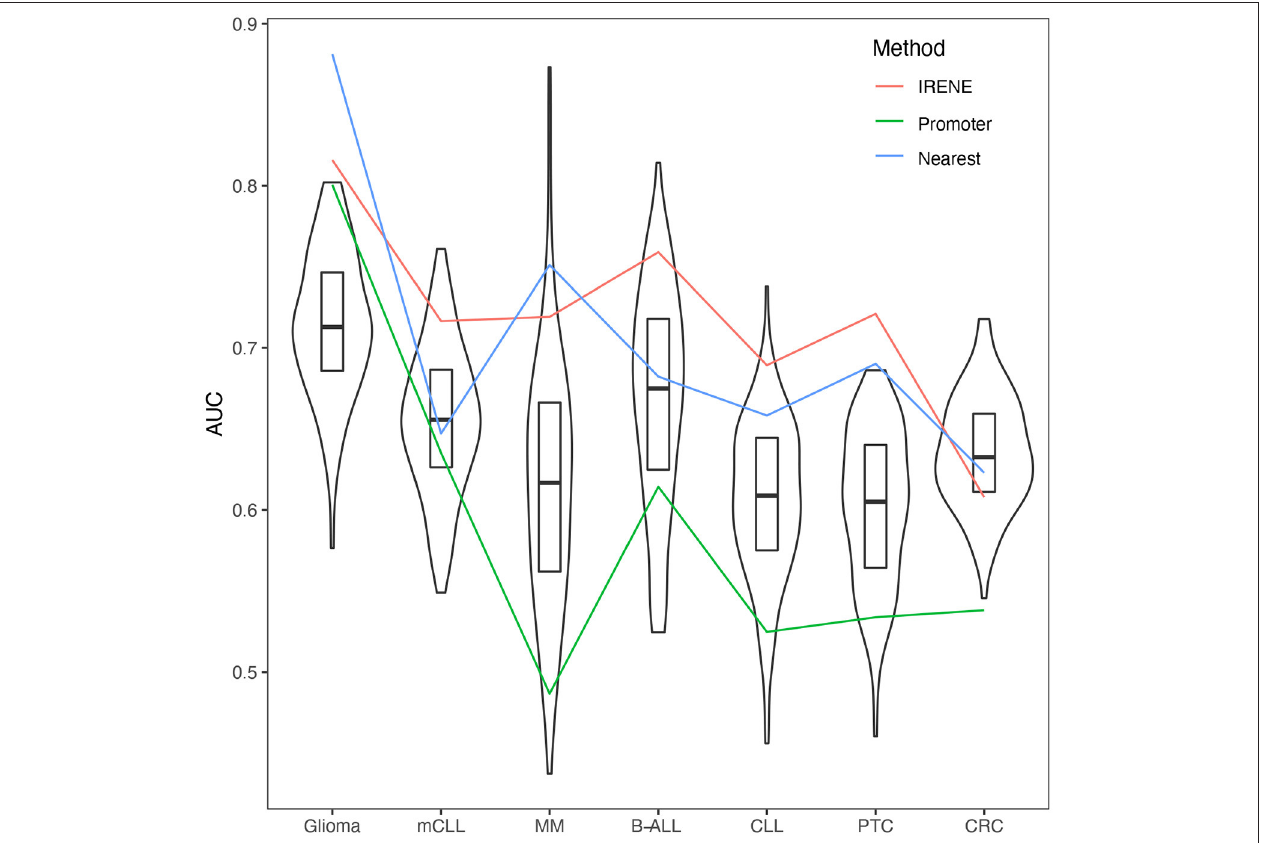
FIGURE 4 | Area under the curves (AUCs) of empirical cumulative density function (ECDF) curves of dPC1+dPC2 ranks from randomized promoter–enhancer interactions. The boxplots indicate the 25–75% quantile ranges from benchmarking each cancer marker gene set with 1,000 different rewired promoter–enhancer networks, whereas the red lines show the AUCs with the original promoter–enhancer interactions from IRENE using experimentally detected interactions (red), and interactions assigned by the nearest promoters (blue), and only promoters (green) rank lists. TABLE 1 | Graph properties in respect of the nodes from the IRENE and promoter rank lists. Node number Median in-degree Median out-degree IRENE Promoter IRENE Promoter IRENE